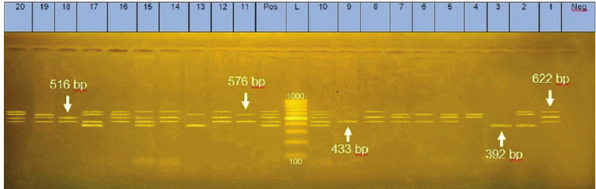
Figure-1: Agarose gel electrophoresis of multiplex PCR showing amplification of five antimicrobial resistance genes, bla at 516 bp, sul 1 at 433 bp aad AA1 at 622 bp, TEM tetA at 576 bp and